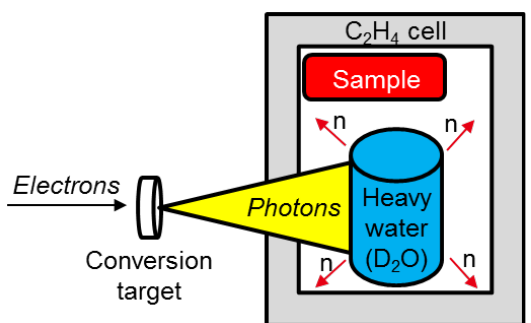
Fig. 2. Photon activation measurement: irradiation step.